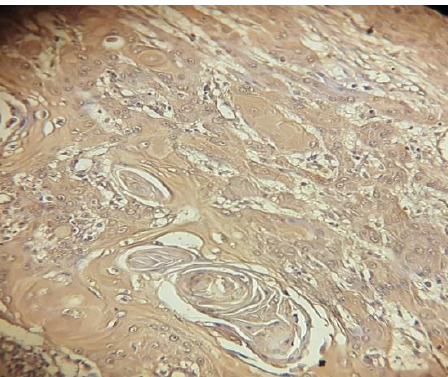
Figure3: Moderate staining (score2 at SIS) of Ang-2 expression in studied samples (X100).